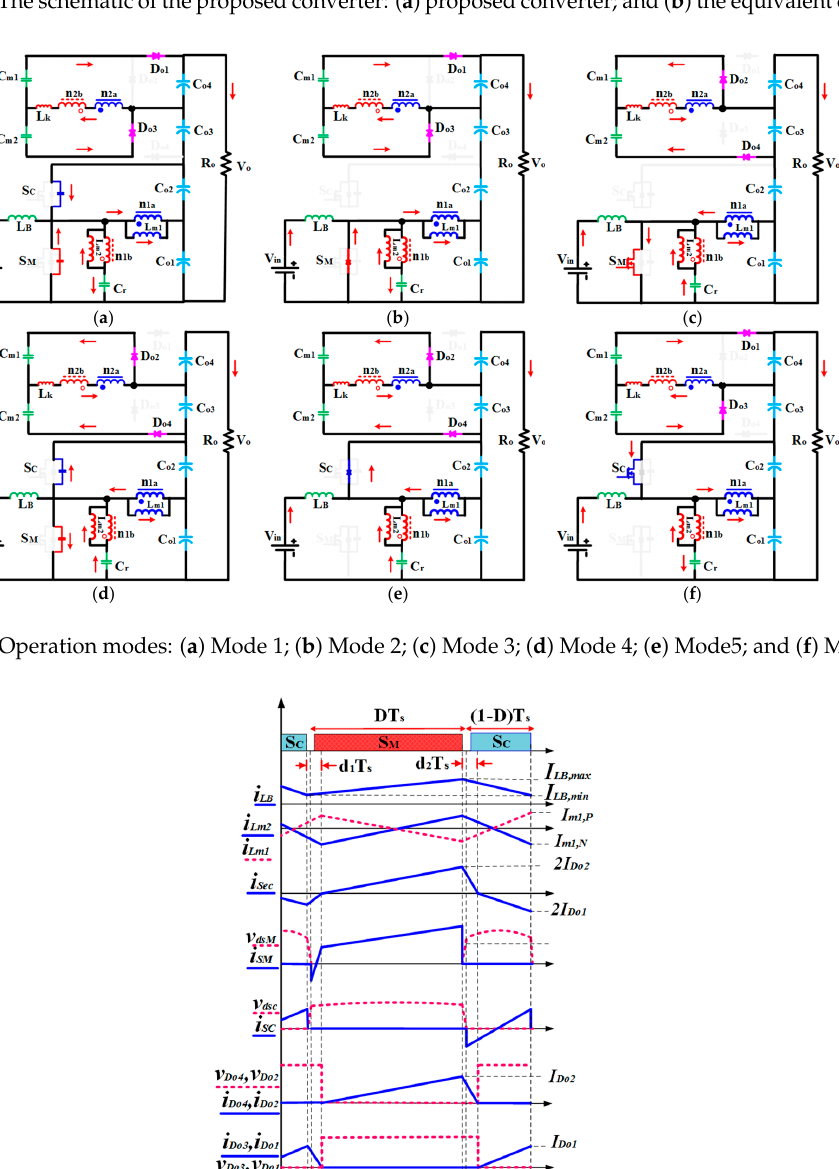
Figure 3. Operation modes: ( a ) Mode 1; ( b ) Mode 2; ( c ) Mode 3; ( d ) Mode 4; ( e ) Mode5; and ( f ) Mode